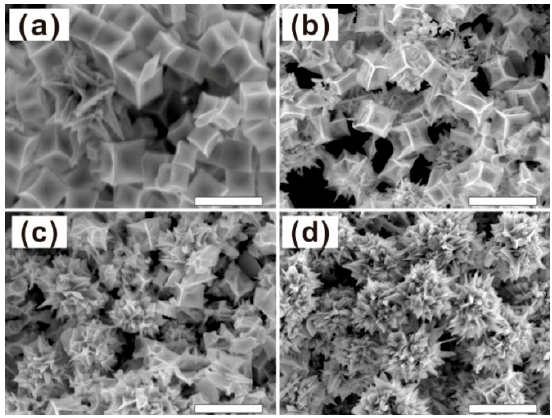
Figure 4. FESEM images of the products obtained after reaction for different durations. ( a ) 1 h, ( b ) 2 h, ( c ) 3 h, ( d ) 6 h. The scale bars are 200 nm.